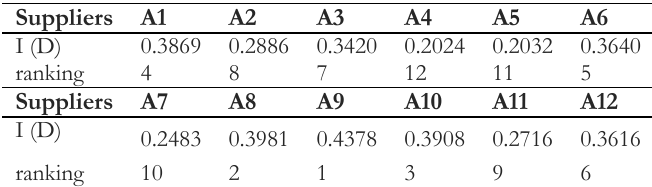
Table 3. Ranking of suppliers of category A parts.